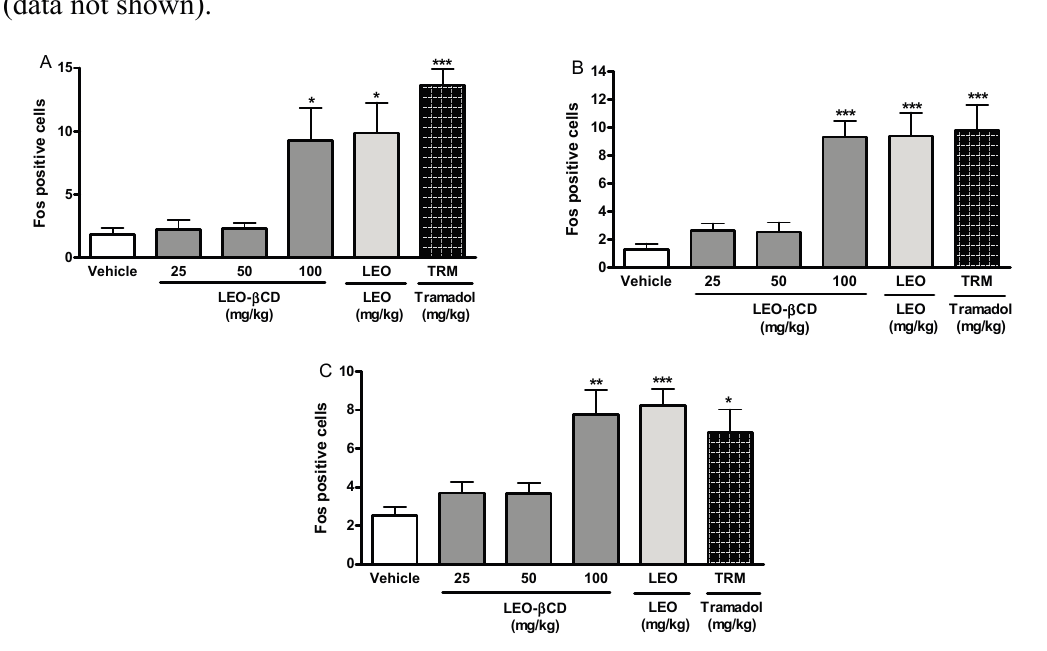
Figure 6. Neurons FOS positive in the periaqueductal grey ( A ); nucleus raphe magnus ( B ) and locus coeruleus ( C ). The animals were treated with vehicle (A; v.o.) LEO (B: 25 mg/kg; v.o.), LEO- β -CD (C: 25, D: 50 and E: 100 mg/kg; v.o.) or TRM (F: 4 mk/kg; i.p.). Values represent in mean ± SEM ( n = 8, per group). * p < 0.05, ** p < 0.01 and *** p < 0.001 vs. control (one-way ANOVA followed by Bonferroni